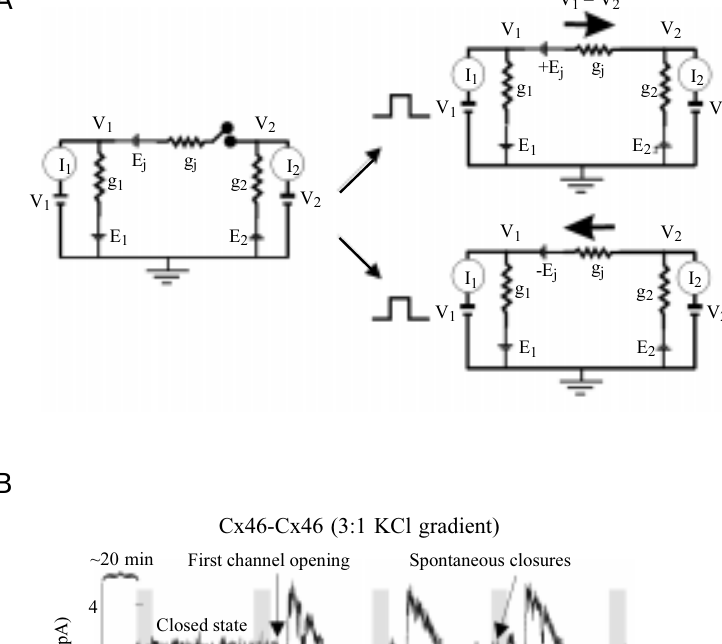
Figure 3 - Selectivity of cell-cell channels measured using the technique of placing cells into contact while recording. A , Equivalent circuit representing a single cell pair in uncoupled (left) and coupled conditions (right). Conductances and associated batteries are indi- cated for each cell membrane and the junctional mem- brane. B , Records showing measurement of